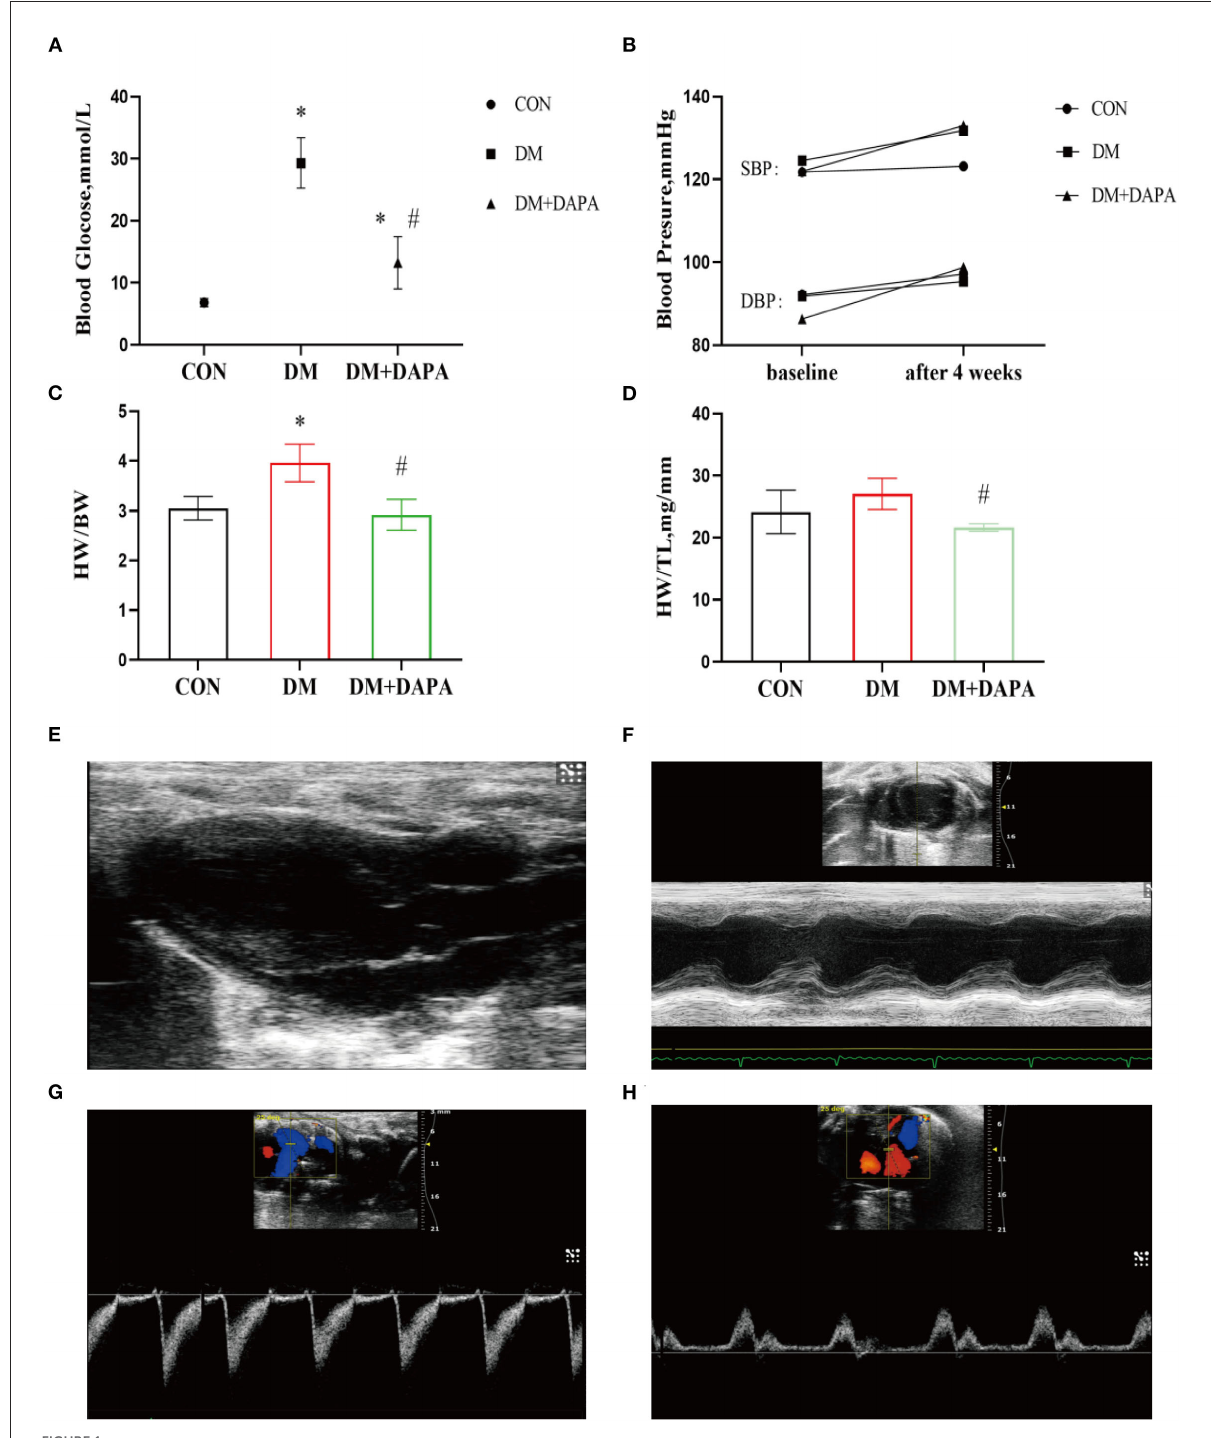
FIGURE1 Effects of DAPA on the basic parameters and cardiac function in STZ-induced diabetic rats. (A) Random blood glucose after 4 weeks among three groups ( n = 8); (B) systolic and diastolic blood pressure in baseline and after 4 weeks ( n = 7); (C) heart weight to body weight (HW/BW) ratio in different groups ( n = 8); (D) heart weight to tibia length (HW/TL) ratio in different groups ( n = 8); (E) parasternal left ventricle long-axis view; (F) M-type echocardiogram of short-axis view; (G) Doppler flow imaging of short-axis view of the heart base; (H) Doppler flow imaging of four-chamber view. CON, control group; DM, diabetes group; DM + DAPA, diabetes + dapagliflozin group; SBP, systolic blood pressure; DBP, diastolic blood pressure. Data are expressed as the mean ± SEM. * P < 0.05 vs. CON group. # P < 0.05 vs. DM